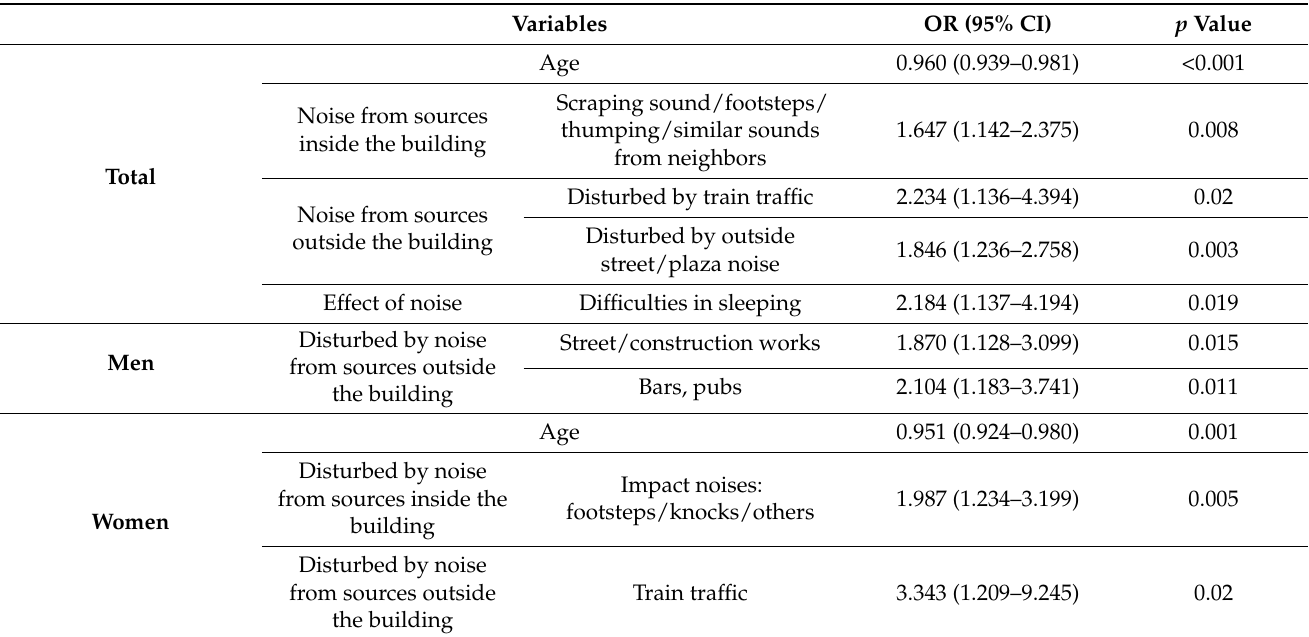
Table 4. Results of the Binary Logistics Regression model. The dependent variable was the Five Well-Being Index (WHO-5) categories as: lower than 50 points (low mood) or higher than or equal to 50 points (normal mood); the independent variables are age, economic status, urban or rural living area, noise exposure time and noise impact level. Only statistically significant variables ( p < 0.05) are included. Variables OR (95% CI) p Value Age 0.960 (0.939–0.981)